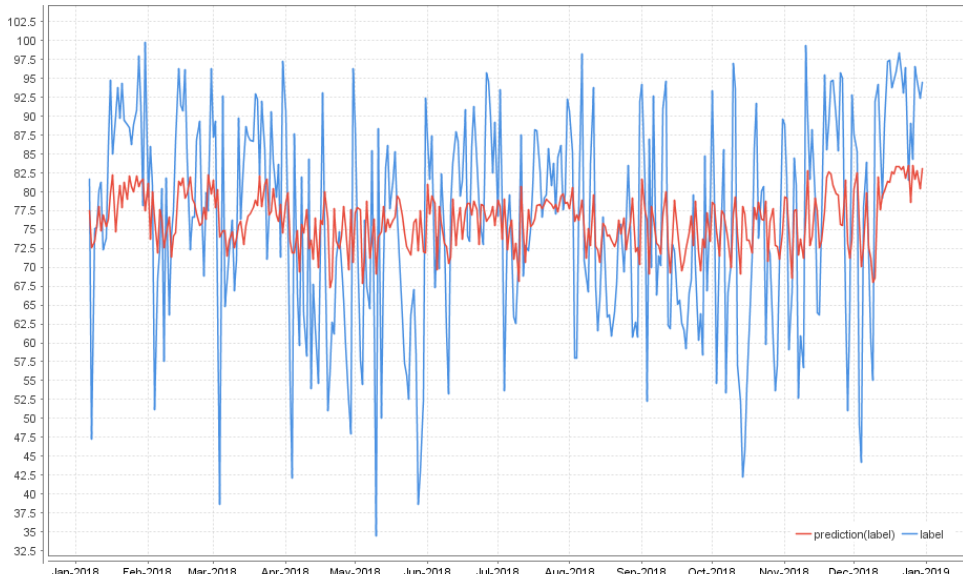
Figure 10. Gradient Boosted Tree (GBT) prediction overview for Sarmasu: CADM + CDM 3 sources scenario: the values for the actual value, in blue, and predicted value, in red ( X -axis) and the time series for which the results were registered ( Y -axis).